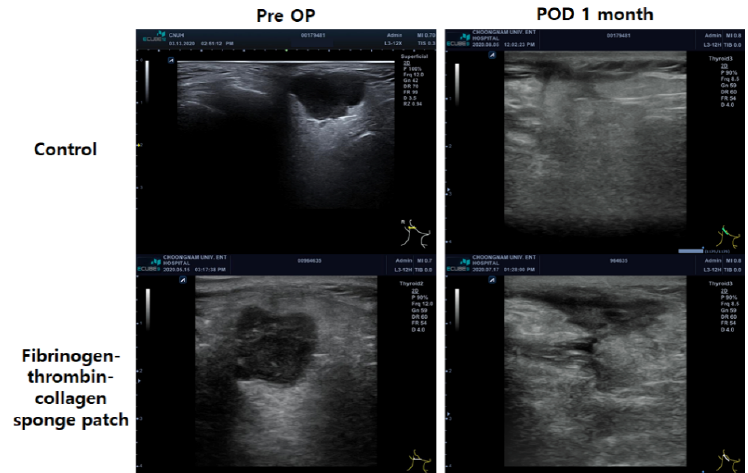
Figure 7. Representative preoperative and 1-month postoperative ultrasonographic images of parotid gland surgery (final diagnosis of benign parotid tumor). Preoperative transverse sonograms show well-circumscribed, multilobulated hypoechoic masses in the superficial lobe of the right parotid gland with posterior acoustic enhancement. Tumors were entirely resected through parotid surgery in both the control and fibrinogen-thrombin-collagen sponge patch groups. The 1-month postoperative transverse sonogram shows an irregularly shaped hypoechoic lesion (thickness: 0.42 cm) in the parotidectomy bed, suggestive of fibrosis. In the fibrinogen-thrombin-collagen sponge patch group, the parotidectomy defect has been replaced by markedly thicker heterogeneously hypoechoic lesions (thickness: 1.1 cm).